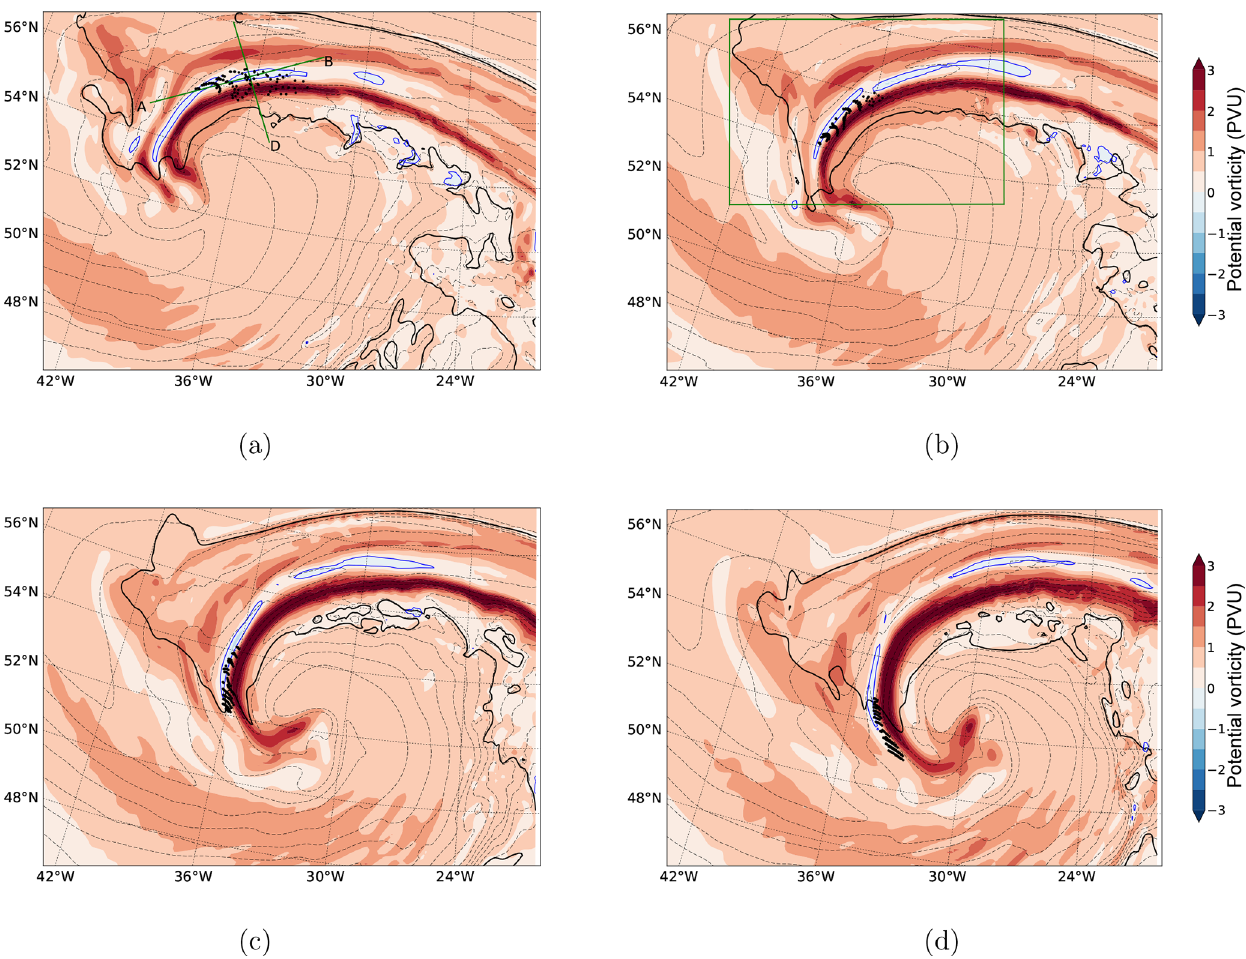
Figure 6. PV (shading; PVU: potential vorticity unit – 1PVU = 10 − 6 m 2 s − 1 Kkg − 1 ), θ w (thin dashed contours every 1K) and cloudy regions (RH ice = 80%; black solid contours) at (a) 700hPa at 83h from run start, (b) 685hPa at 86h, (c) 715hPa at 89h and (d) 745hPa at 91h. Black dots show the locations of the trajectories. The two green lines, AB and CD, in panel (a) , indicate the locations of the cross sections shown in Figs. 7 and 8, while the green box in panel (b) indicates the domain plotted in Fig.